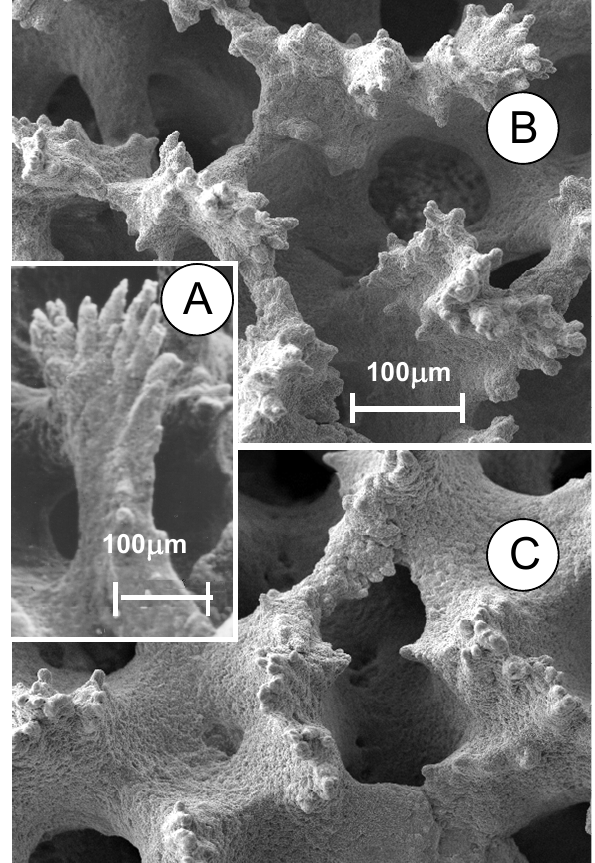
Fig. 2. (A) The tips of a growing septa of Porites lutea is covered in dentations, each consisting of an array of fine spines like fingers from a hand. (B) At night, calcification results in the elongation of the fingers by accretion of new calcification centers at the growing tips; thus the septal surface appears spiky. (C) During the day, the spaces between adjacent fingers are filled in by outward growth of aragonite fibre bundles. By the end of the day the surface of the sep- tum has a smooth appearance. (Images courtesy of David Barnes, Australian Institute of Marine